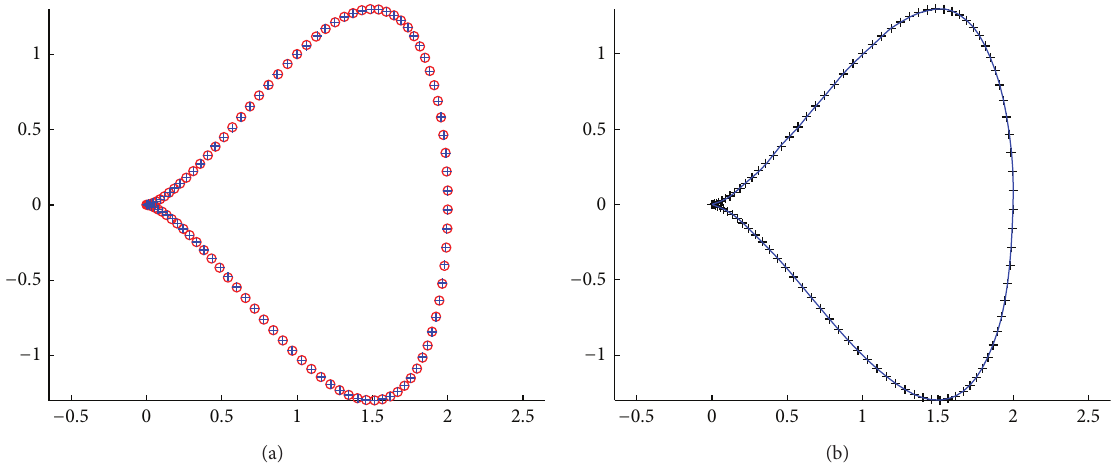
Figure 4: Application of the cuckoo search algorithm to the piriform curve example: (a) original data points (red emptied circles) and reconstructed points (in blue plus symbol); (b) data points (black plus symbol) and fitting curve (solid blue line).